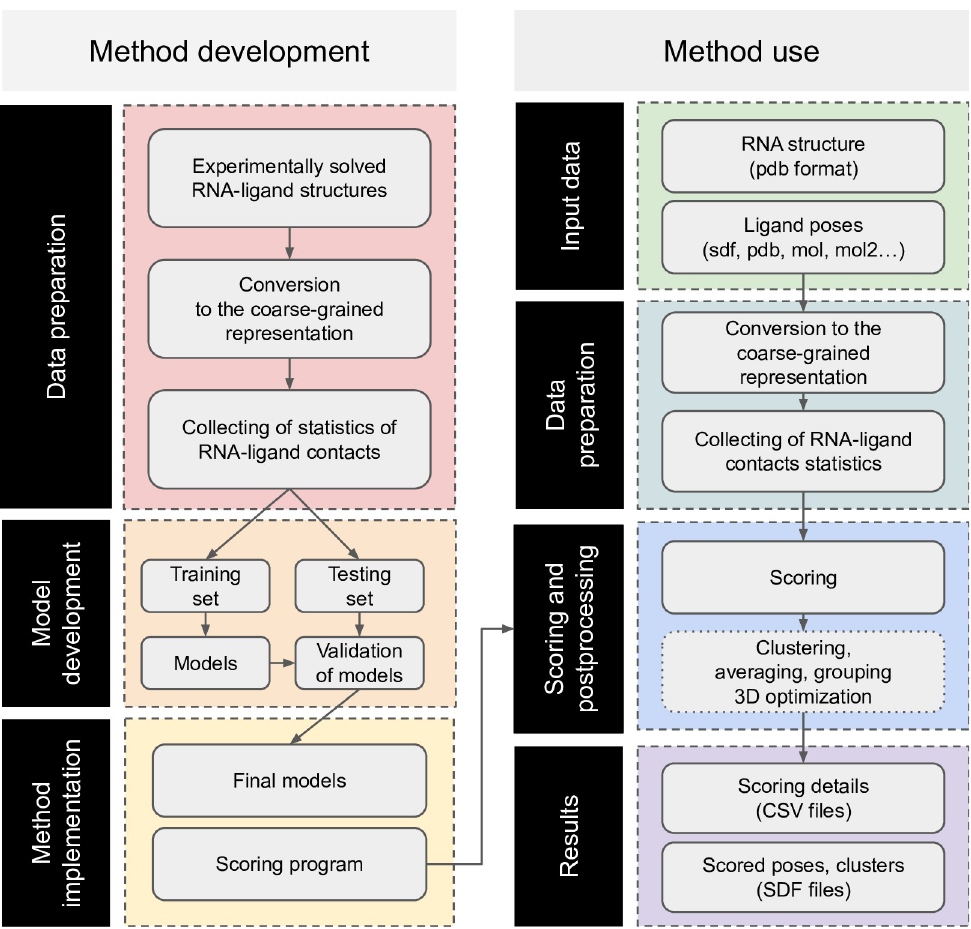
Fig 8. The workflow of AnnapuRNA. The left column represents the method development pipeline, while the right one displays the method usage. Optional post-processing steps are placed in boxes with a dotted border.